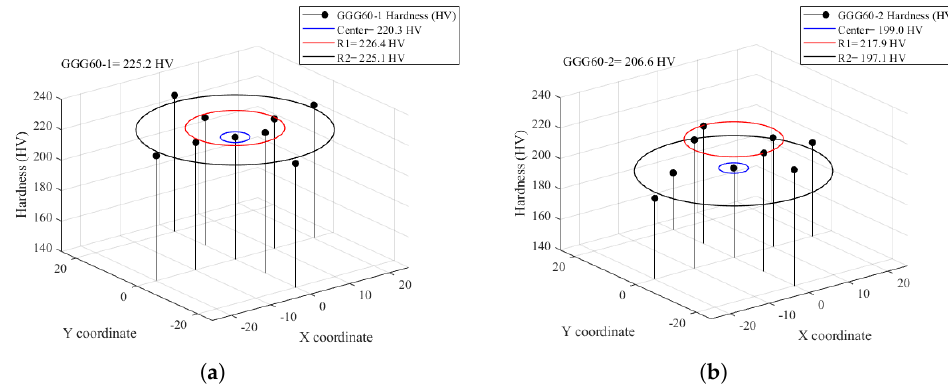
Figure 16. Hardness test round bar sample. ( a ) GGG60-1. ( b ) GGG60-2.